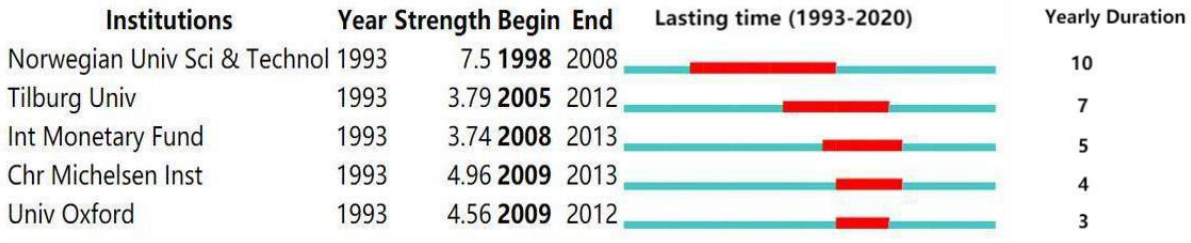
Figure 7. Institutes with occurrence explorations during 1993–2020. Table 2. The top 20 institutes with documents and citations. Rank.